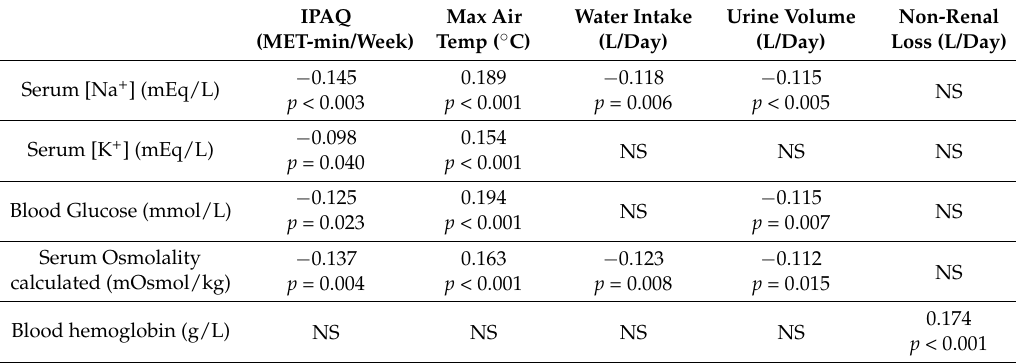
Table 4. Correlation ( r Pearson) between blood variables and physical activity, air temperature and 24-h water intake/ fluid